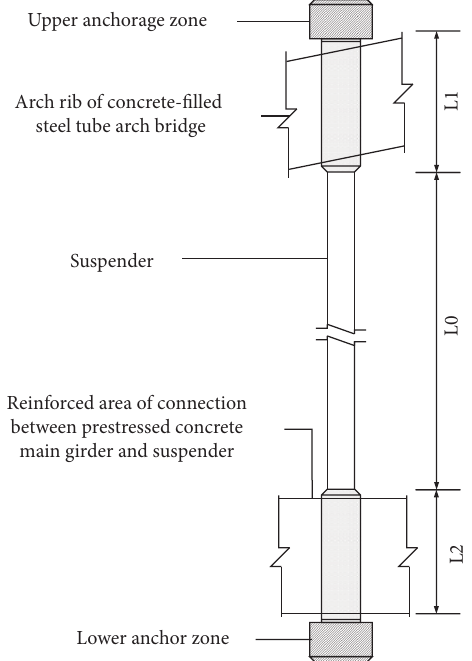
Figure 19: Structural sketch of suspender.